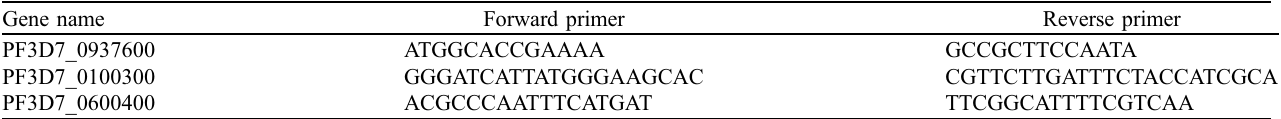
Table 1. The primer sequences of quantitative